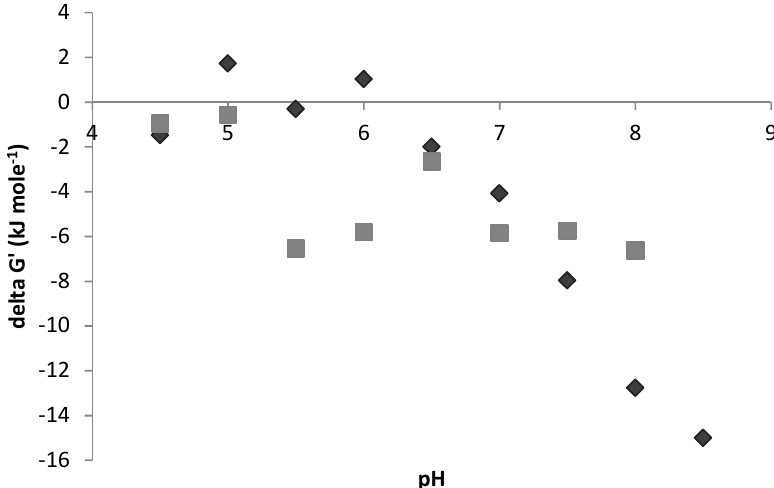
Figure 6. Gibbs free energy (kJ/mole) for the reaction CO 2 + H 2 ↔ HCOOH of reset pH approach (grey square) and progressive pH approach (dark diamond). Equation Δ G’ = Δ G° + RT ln Q, where Δ G° = Δ H° − Δ S° is used for calculation.